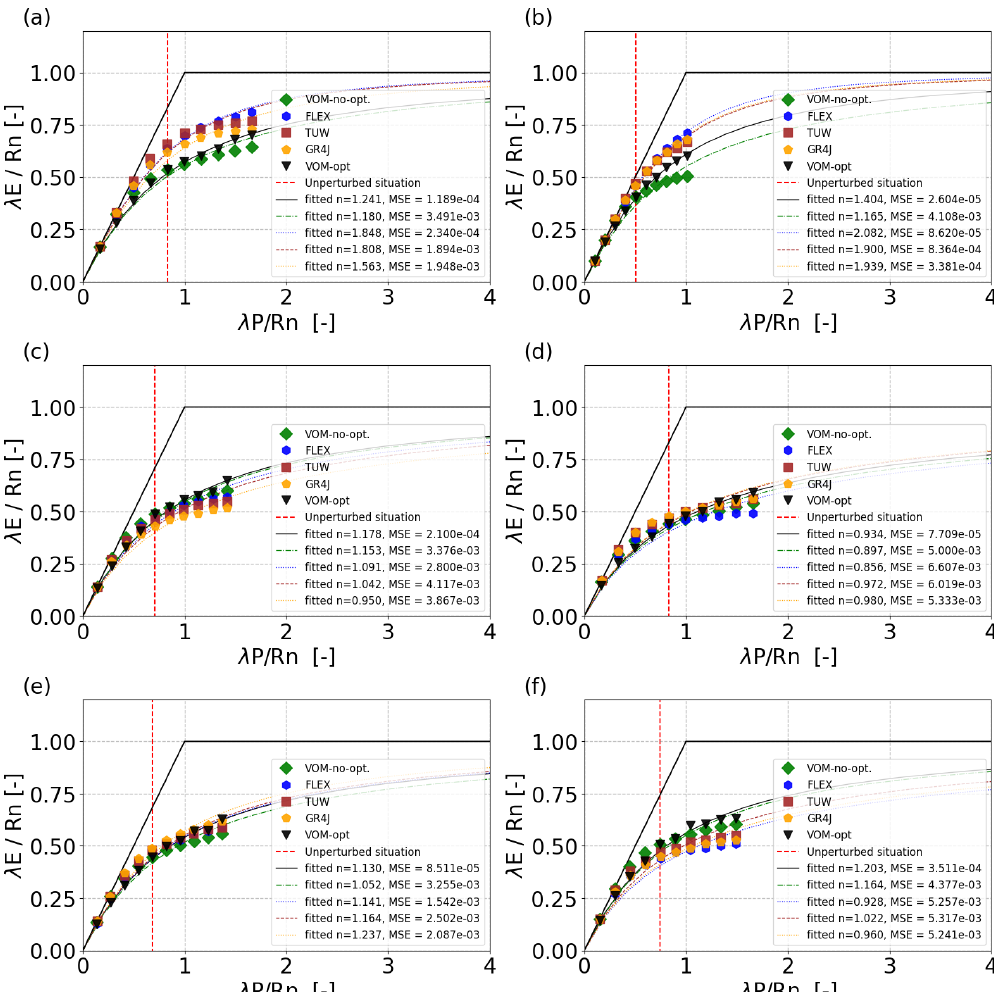
Figure 7. Simulations in Budyko space for six catchments in Australia as a result of modified precipitation for the optimized VOM (black stars), VOM without optimization (green triangles), FLEX (red diamonds), TUWmodel (gray dots), and GR4J (gold squares) for (a) Adelaide River, (b) Dry River, (c) Fergusson River, (d) Magela Creek, (e) Seventeen Mile Creek, and (f) South Alligator River. The unmodified climate is indicated by the dashed red